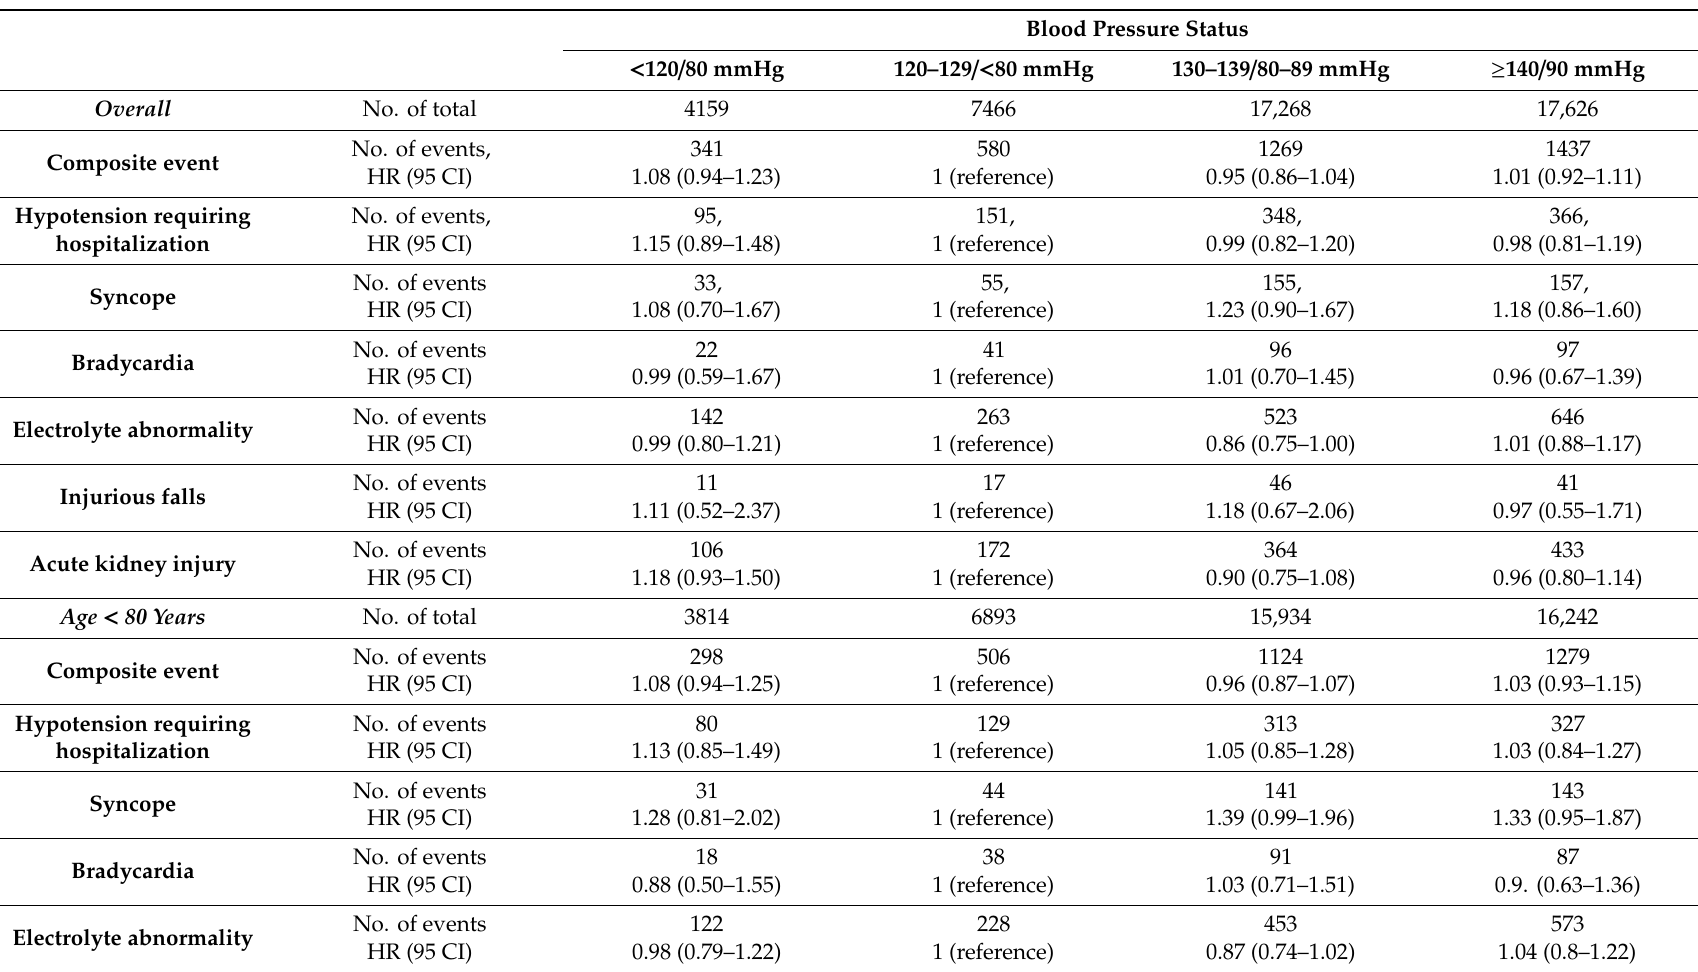
Table 4. Incidence Rate and Hazard Ratio of Serious Adverse Events According to Blood Pressure Status in Patients with Hypertension